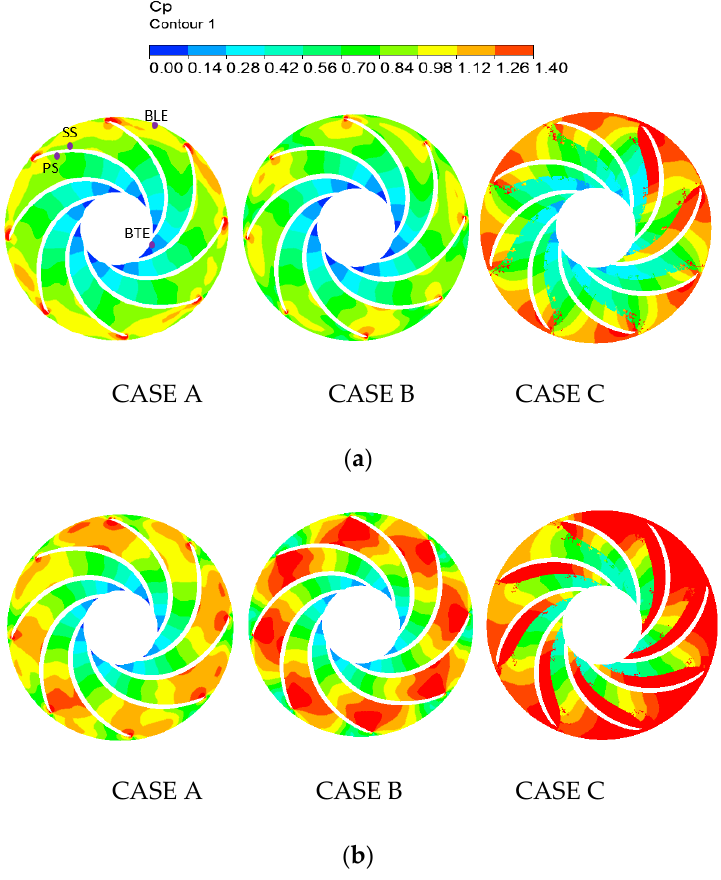
Figure 13. Pressure distribution within the impeller of optimized cases A, B and C under flow conditions of: ( a ) 1.0 Q d ( b ) 1.2 Q d and ( c ) 1.4 Q d